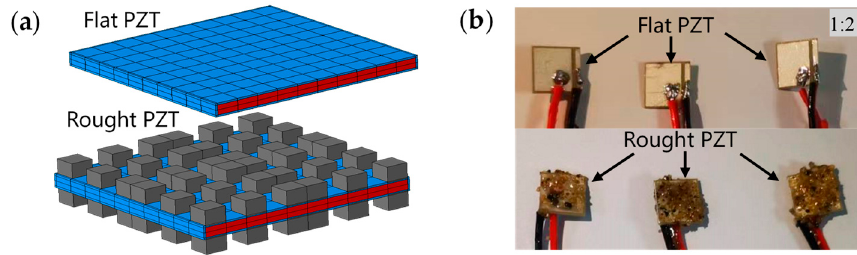
Figure 1. Typical FE model ( a ) for the fabricated PZT sensors ( b ). Table 1. Physical properties of PZT and epoxy.